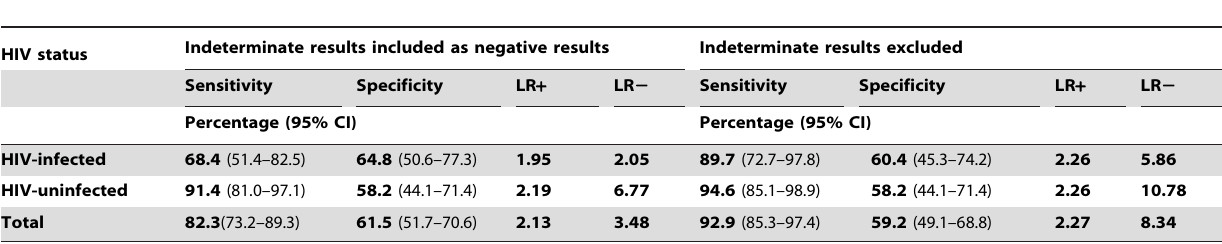
Table 4. Diagnostic values of QFT-GIT in active pulmonary TB patients stratified by HIV status calculated over the total of patients tested (indeterminate results included as negative results) and only over the interpretable results (indeterminate results excluded).